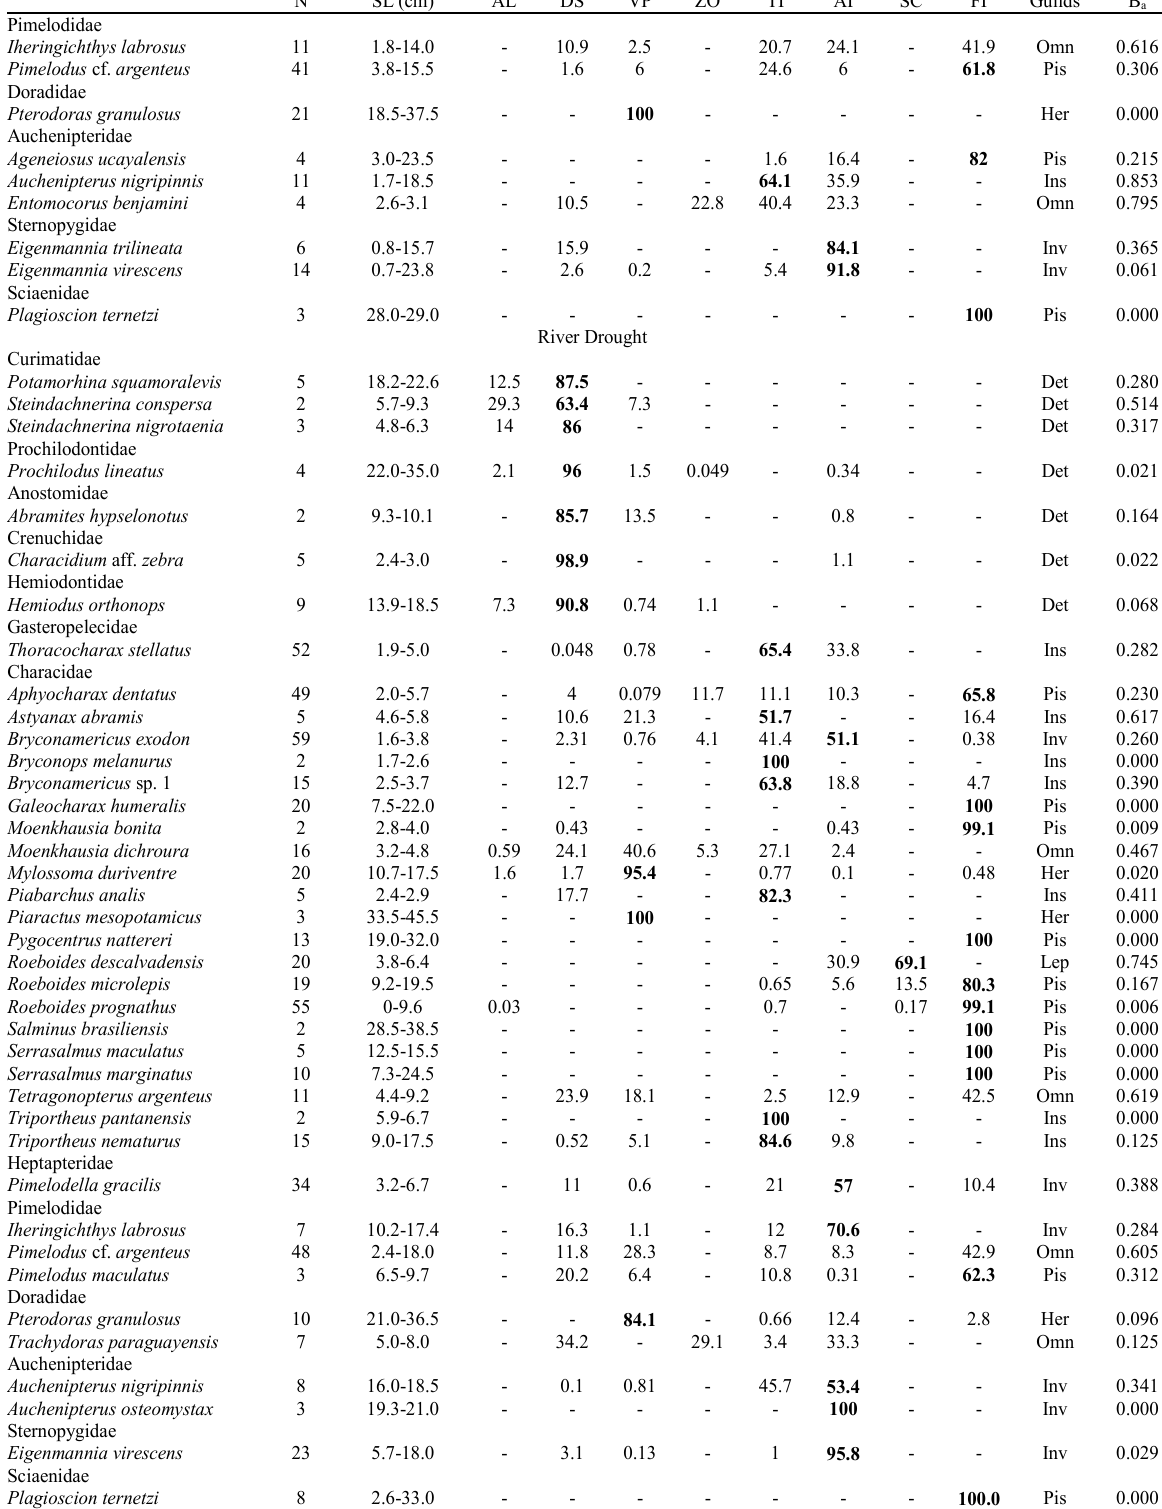
Table 1 (cont.). Diet composition (volume %) of the fish fauna in the seasonal Brazilian Pantanal, Cuiabá River basin, Mato Grosso State, Brazil. N = stomach contents analyzed. SL = standard length. AL = algae, DS = detritus/sediment, HP = vascular plant, ZO = zooplankton, TI = terrestrial insects, AI = aquatic invertebrates. SC = scales, FI = fish. Number in bold indicate the main food resource (V > 51%). B = standardized trophic niche a